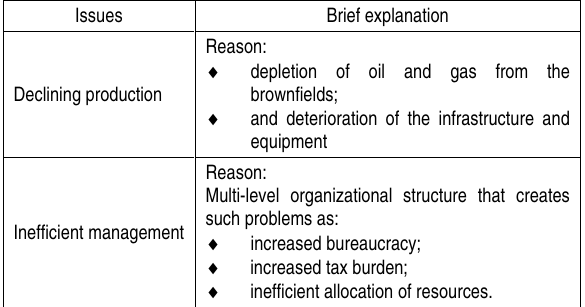
Table 1. Issues in the oil and gas industry